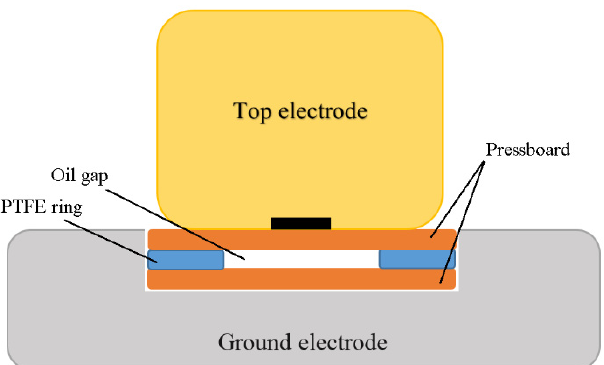
Figure 23. The structure of insulation system and electrode system [48].